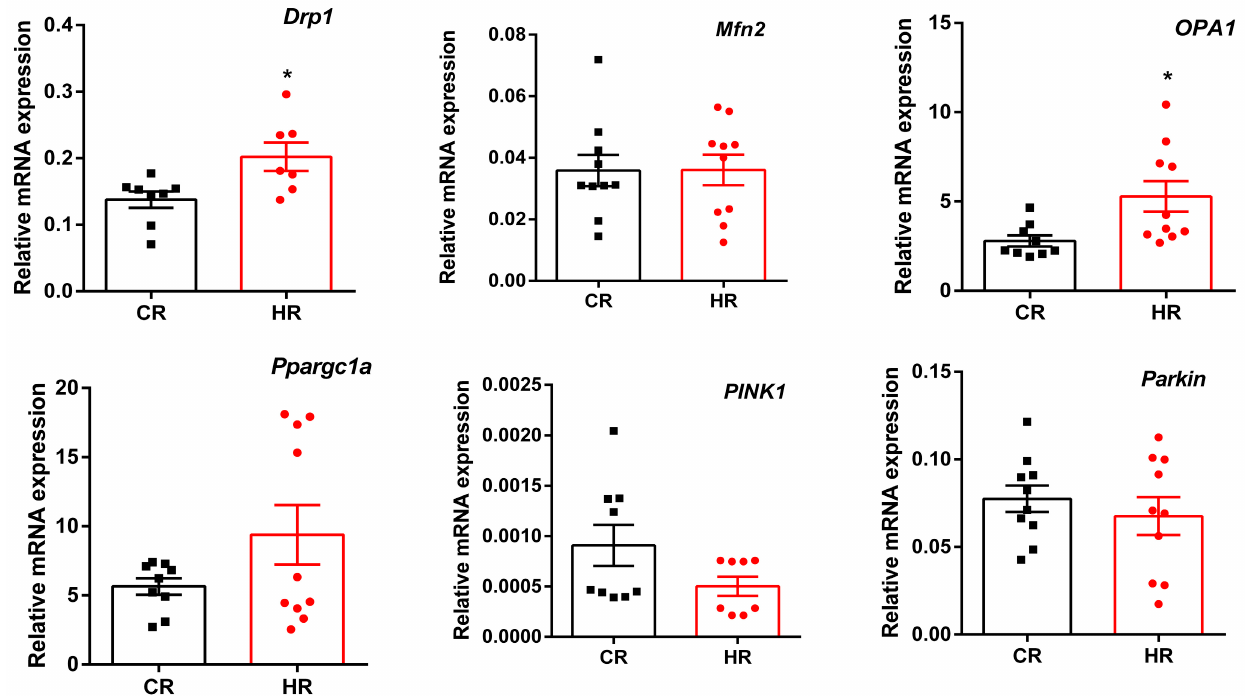
Figure 3. Quantitative real-time PCR analysis of the mRNA expression of mitochondrial dynamics, biogenesis and mitophagy genes in heart of experimental animals. CR, control; HR, hyperthyroidism. * p < 0.05, as compared with the control data (n = 8).